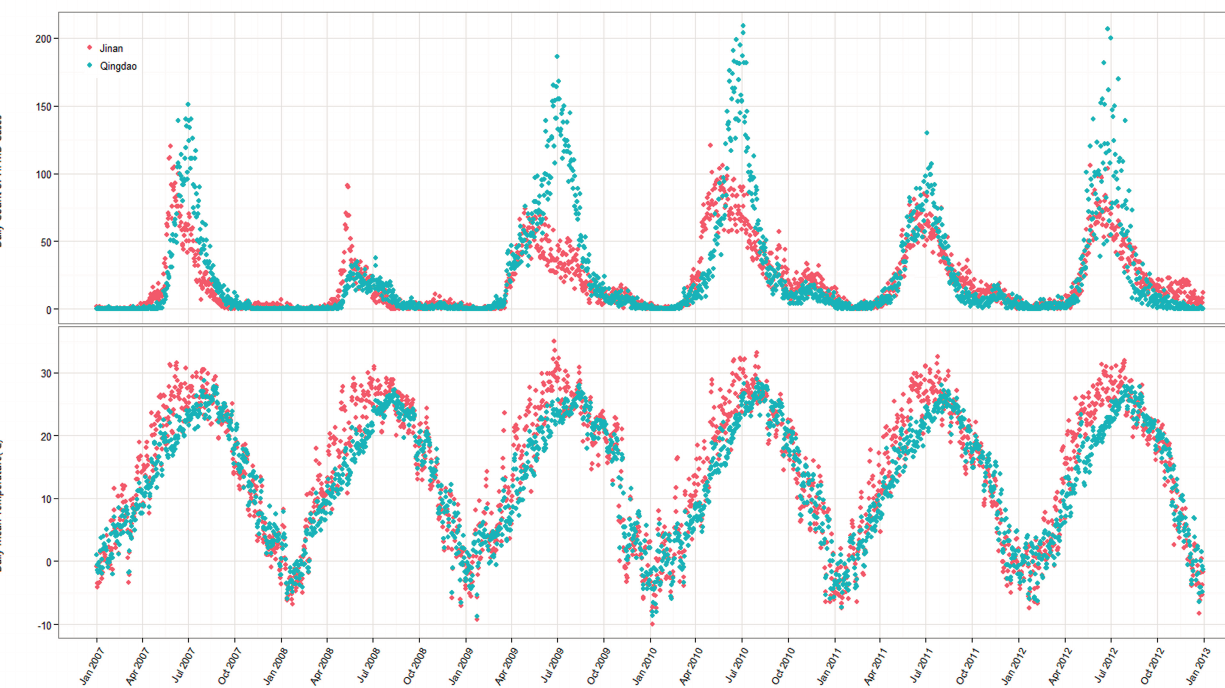
Figure 2. The daily distribution of HFMD incidence and mean temperature in Jinan and Qingdao, 2007–2012 (unit: incidence (per 100,000), temperature